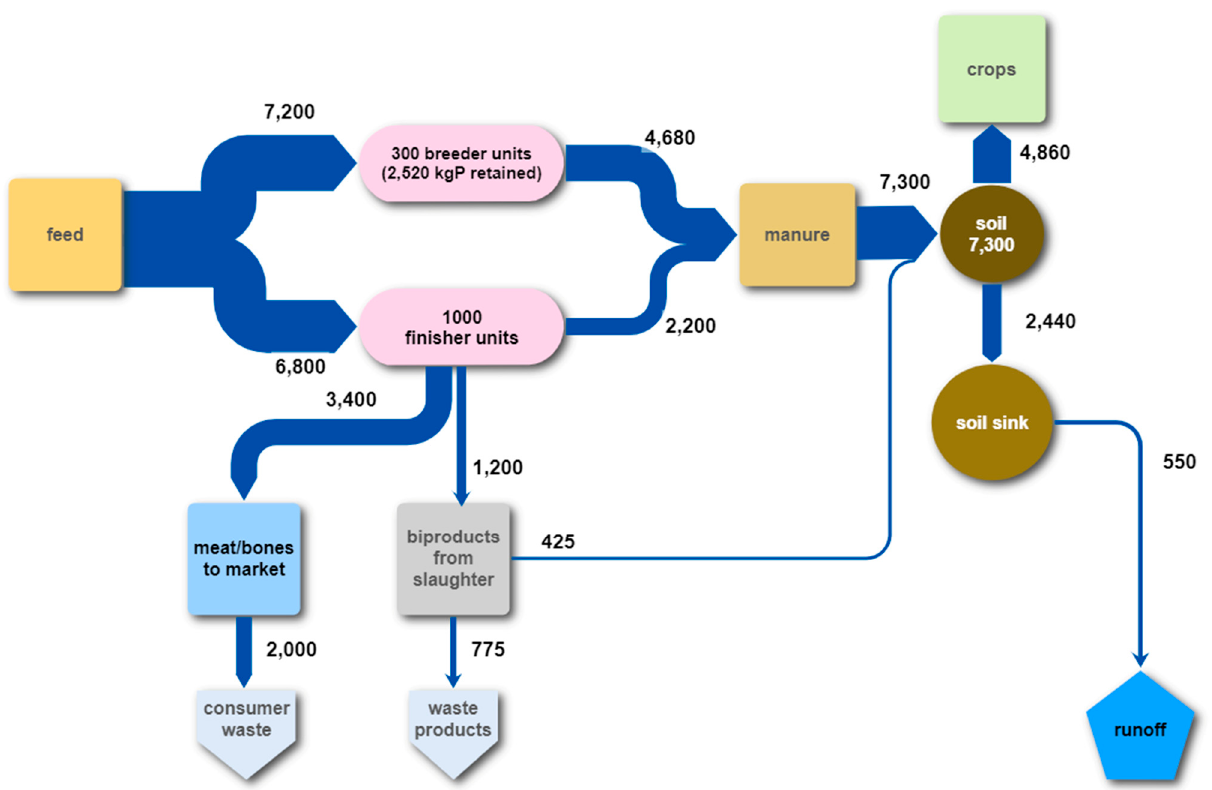
Figure 5. Annual mass balance of P (kgs) in a typical pig farm with 300 sow (breeder) units and 1000 finisher units. Feed input represents 14,000 kg P. The cropland area receiving manure was 183 ha. Based on data derived from [69].